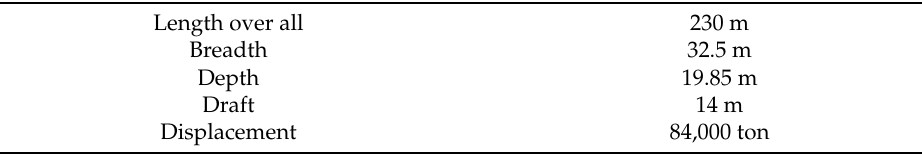
Table 2. Ship’s specifications. Table 3. Natural period of the Delta and the berthed ship